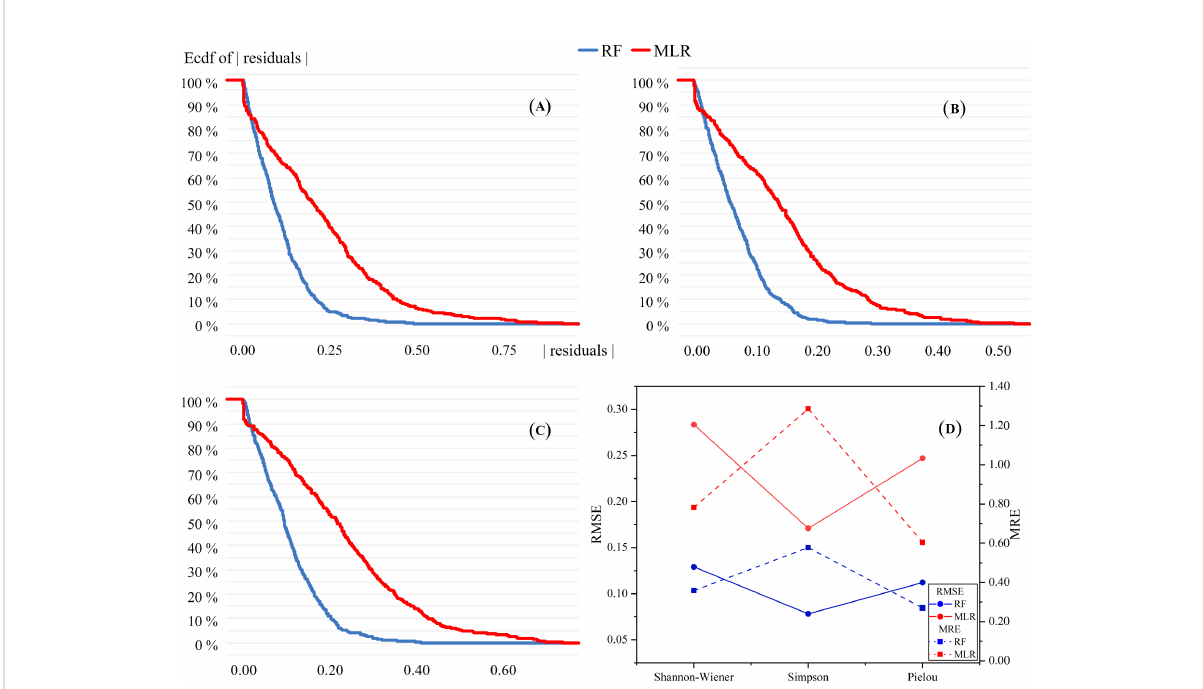
FIGURE 5 Reverse cumulative distribution of residuals of MLR and RF models. (A – C) represent Shannon – Wiener, Simpson and Pielou diversity indices, respectively. (D) is the results of RMSE and MRE of the two prediction